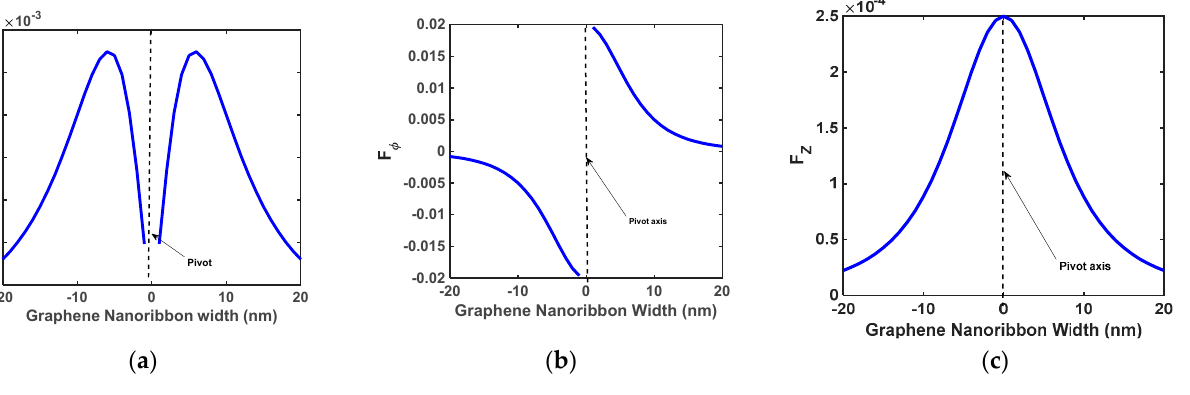
Figure 6. The force applied to each section ( z = z gi ) of the graphene nanoribbon sheet through the quantum array in the ( a ) r -direction, ( b ) ϕ -direction, and ( c ) z -direction.